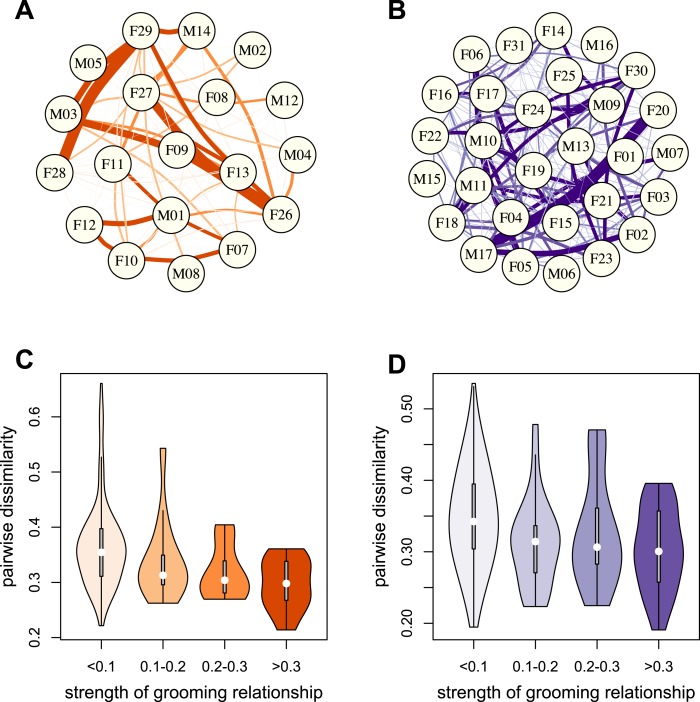
Grooming-based social networks predict microbiome composition.Social networks based on grooming interactions in the year prior to and including the month of microbiome sampling in (A) Mica's and (B) Viola's social groups. Each circle represents an individual (with the individual's ID listed within the circle). Lines represent grooming interactions between individuals, and heavier lines reflect stronger grooming relationships. (C and D) Violin plots depicting the relationships between pairwise grooming bond strength vs pairwise Bray–Curtis dissimilarity in taxonomic composition in Mica's and Viola's groups, respectively. White dots represent median values and grey rectangles represent the first and third quartiles of the data. Rotated kernel density plots representing the underlying data are shown on each side. Stronger bonds predict more similar gut microbiotas in both groups (Mica's group: Mantel test r = −0.257, p = 3.0 × 10−4; Viola's group: r = −0.173, p = 8.0 × 10−4). Parallel results based on de novo assembly are shown in Figure 2—figure supplement 1.